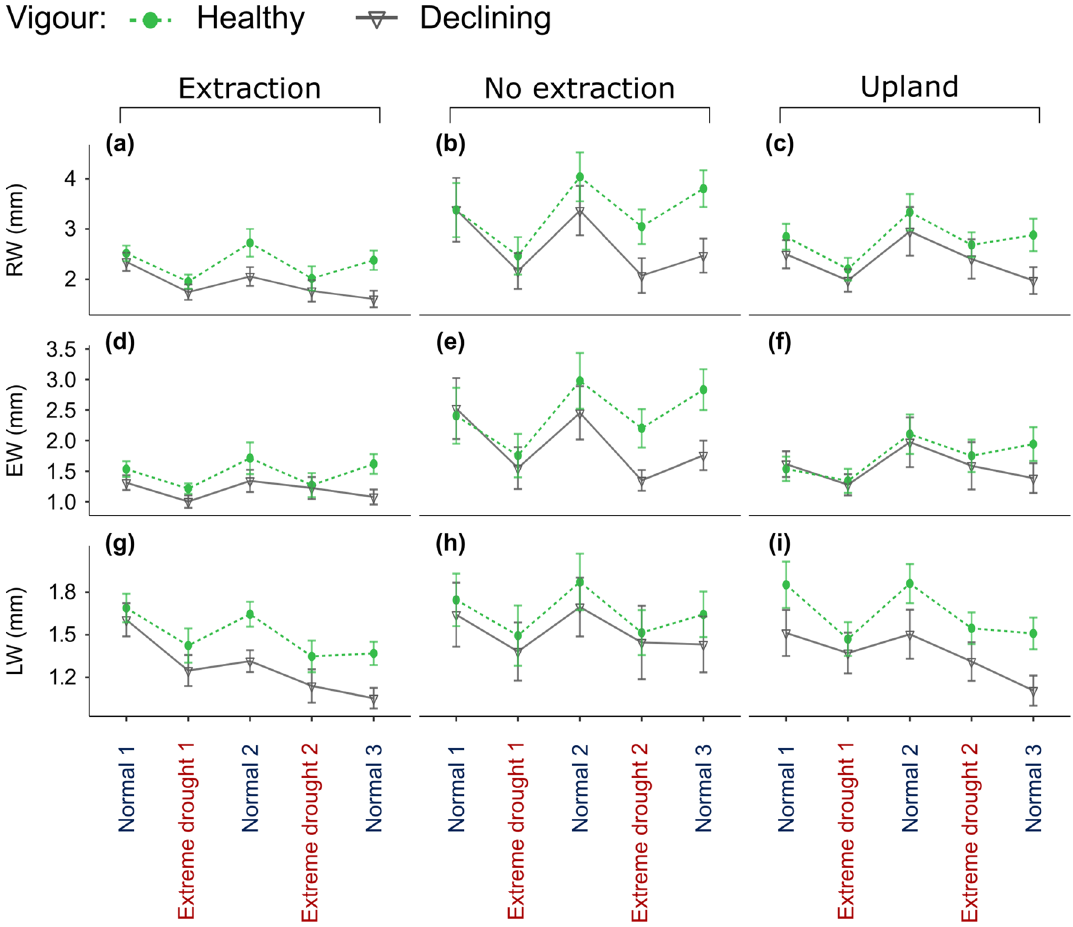
Figure 4. Development of growth variables: ( a – c ) ring-width (RW); ( d – f ) earlywood-width (EW); ( g – i ) latewood-width (LW), in the two droughts as well as pre, and post-drought (normal) periods for trees from different vigour groups and for sites with different groundwater regimes. See also Supplementary Fig. S3 for the exact non-dry years considered in the pre- and post-drought periods. Points show average values of each ring- width variable and bars show the standard error of the